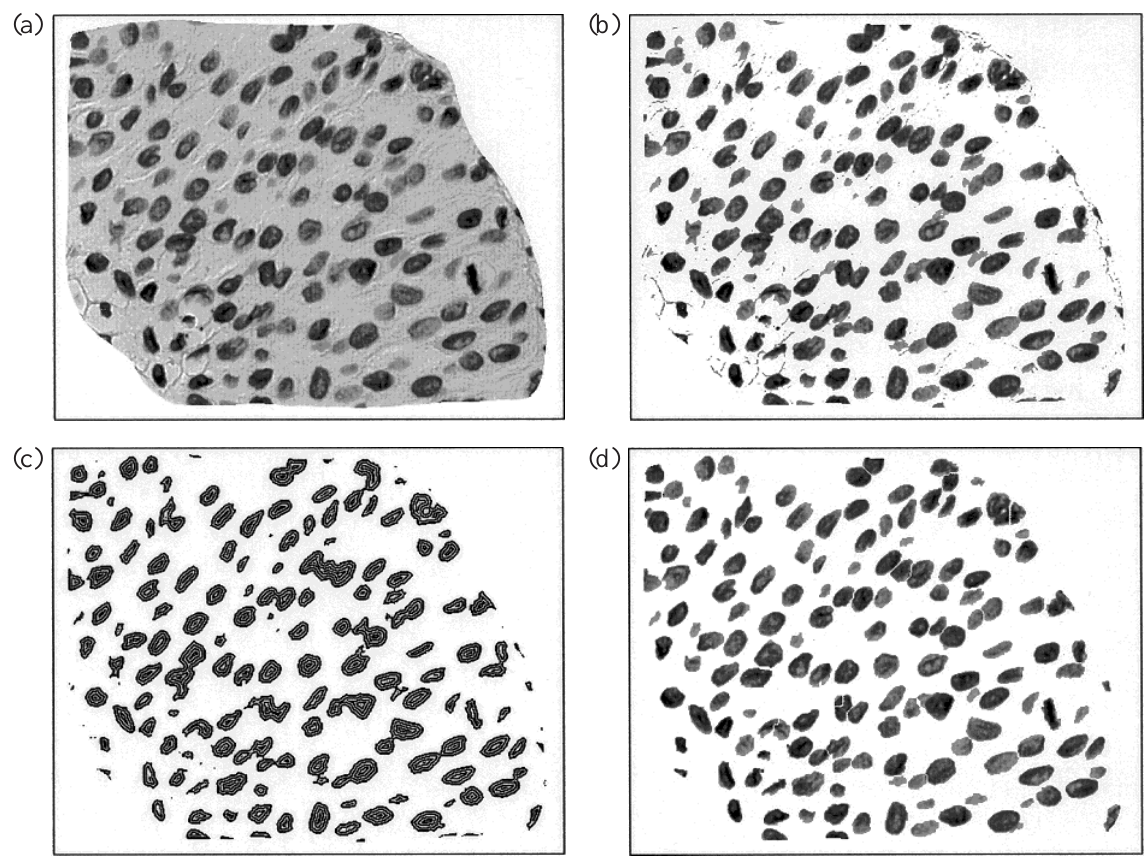
Fig. 3. (a) The Grade 2A image. (b) Cell nucleus segmentation of histogram-based global thresholding. (c) Using of a chamfer 3–4 distance transformation. (d) The overlapping nuclei separated by watershed